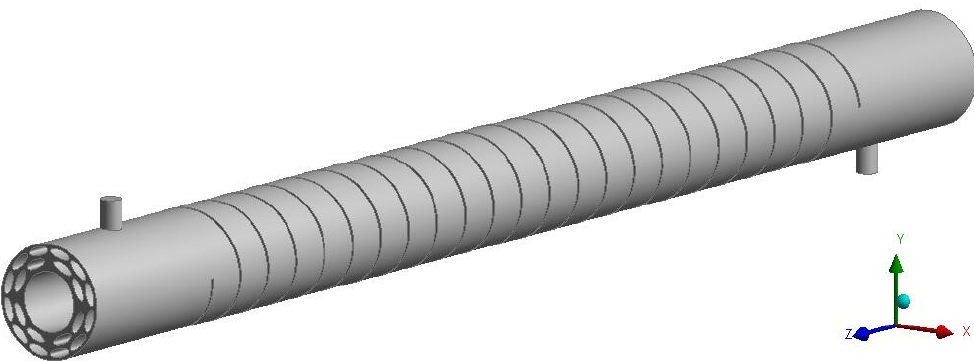
Figure 2. 3D geometry of tested heat exchanger.